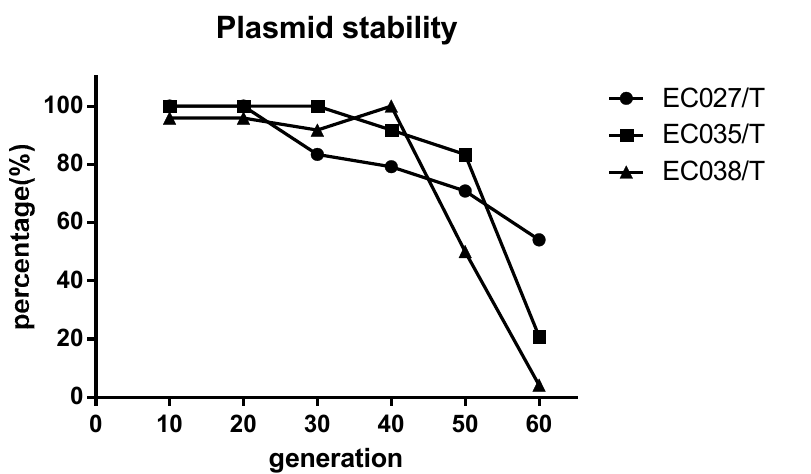
Figure 3. Stability test of sul3 positive wild plasmid. The positive rate of sul3 remained above 70%